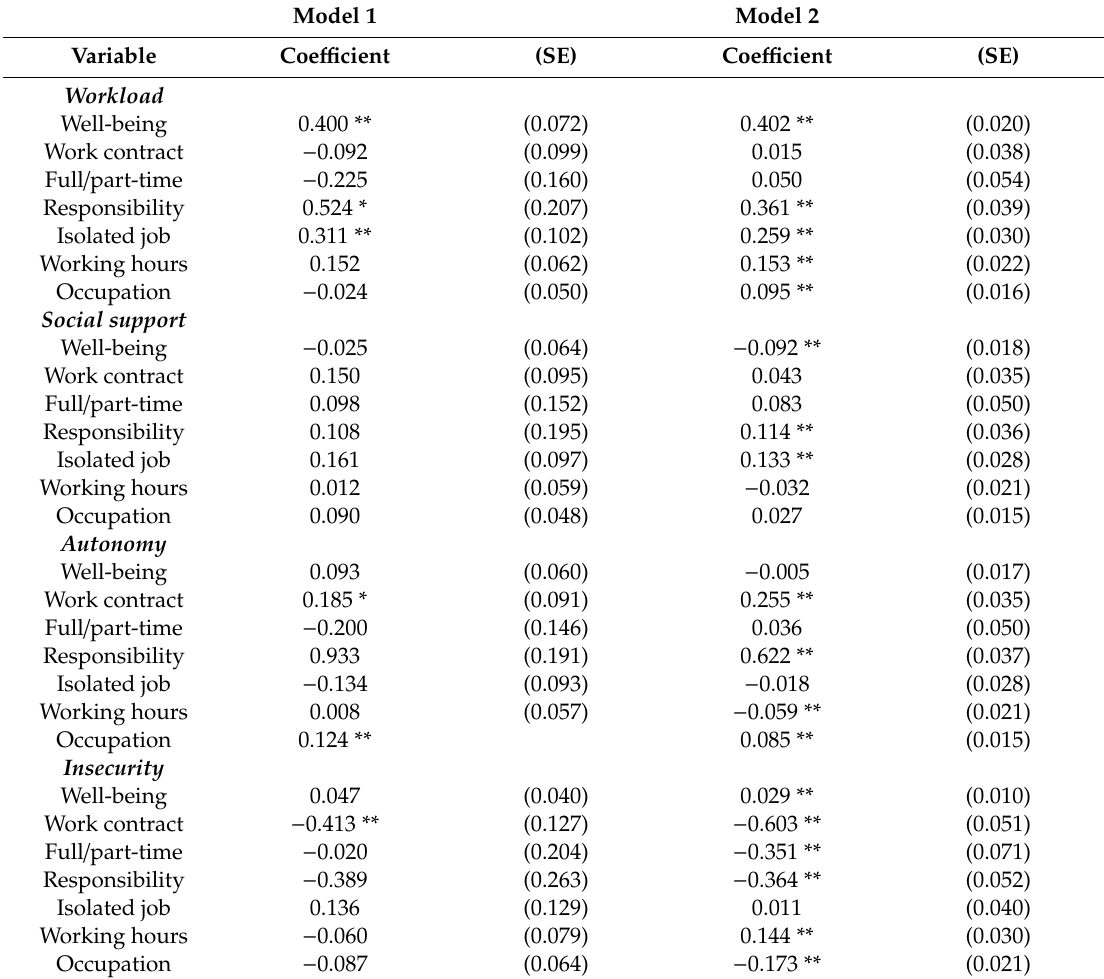
Table 5. Model coe ffi cients and the standard error for linear regressions in migrant workers (Model 1) and native workers (Model